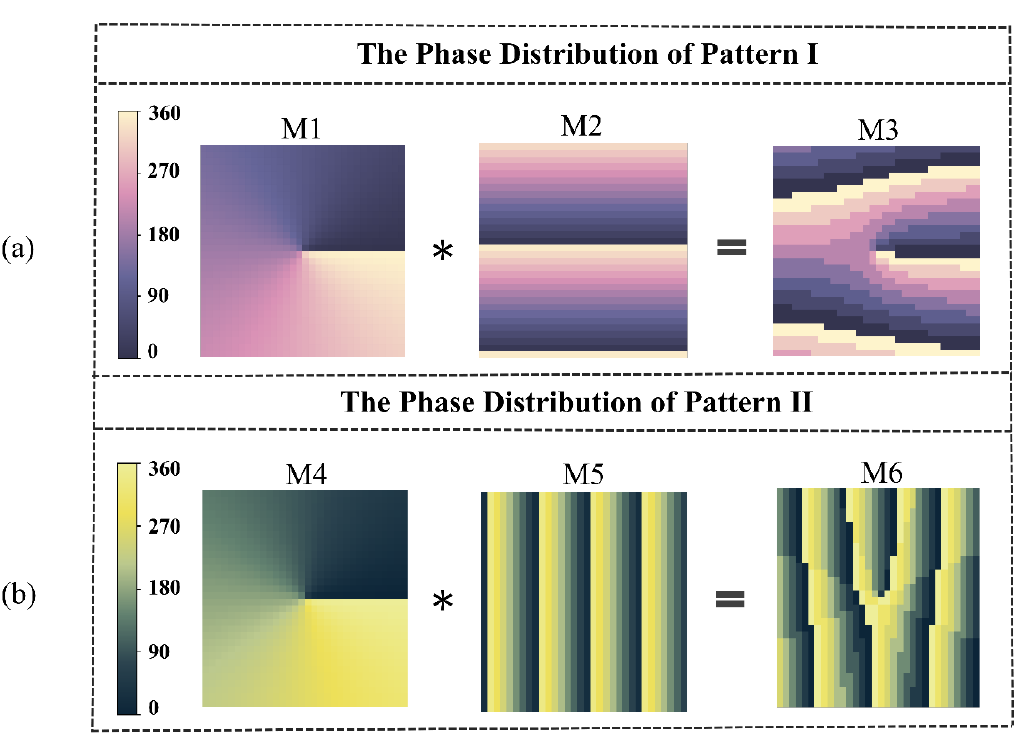
Figure 3. Phase distribution of the single beam dual-function OAM generator based on 3-bit coding unit cells. (Here, ‘*’ means the convolution operation.) ( a ) Phase distribution of the l 1 = + 1 deflected vortex beam at 0.6 THz under the y -polarized incidence. ( b ) Phase distribution of the l 2 = + 1 deflected vortex beam at 0.9 THz under the x -polarized incidence.